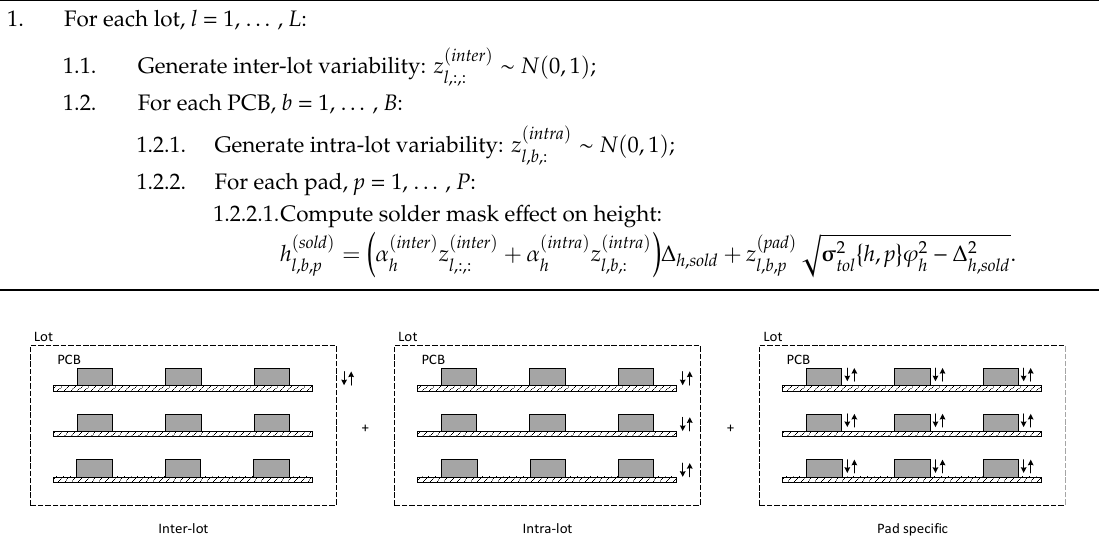
Figure 5. Schematic representation of inter-lot, intra-lot and pad specific components used to generate the solder mask effect on height.